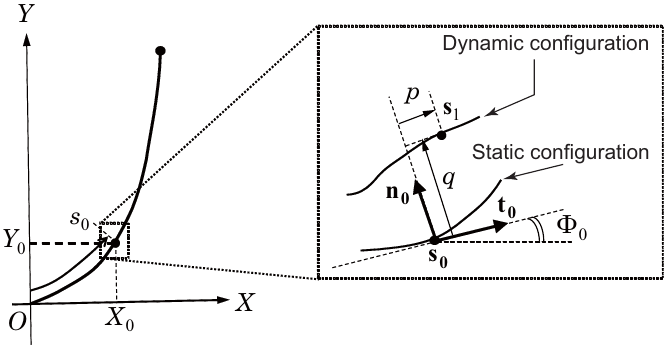
Figure 2. O – XY Cartesian and arc-length ( s ) coordinate systems. The dashed box enlarges a point on the cable to denote the definition of angles and